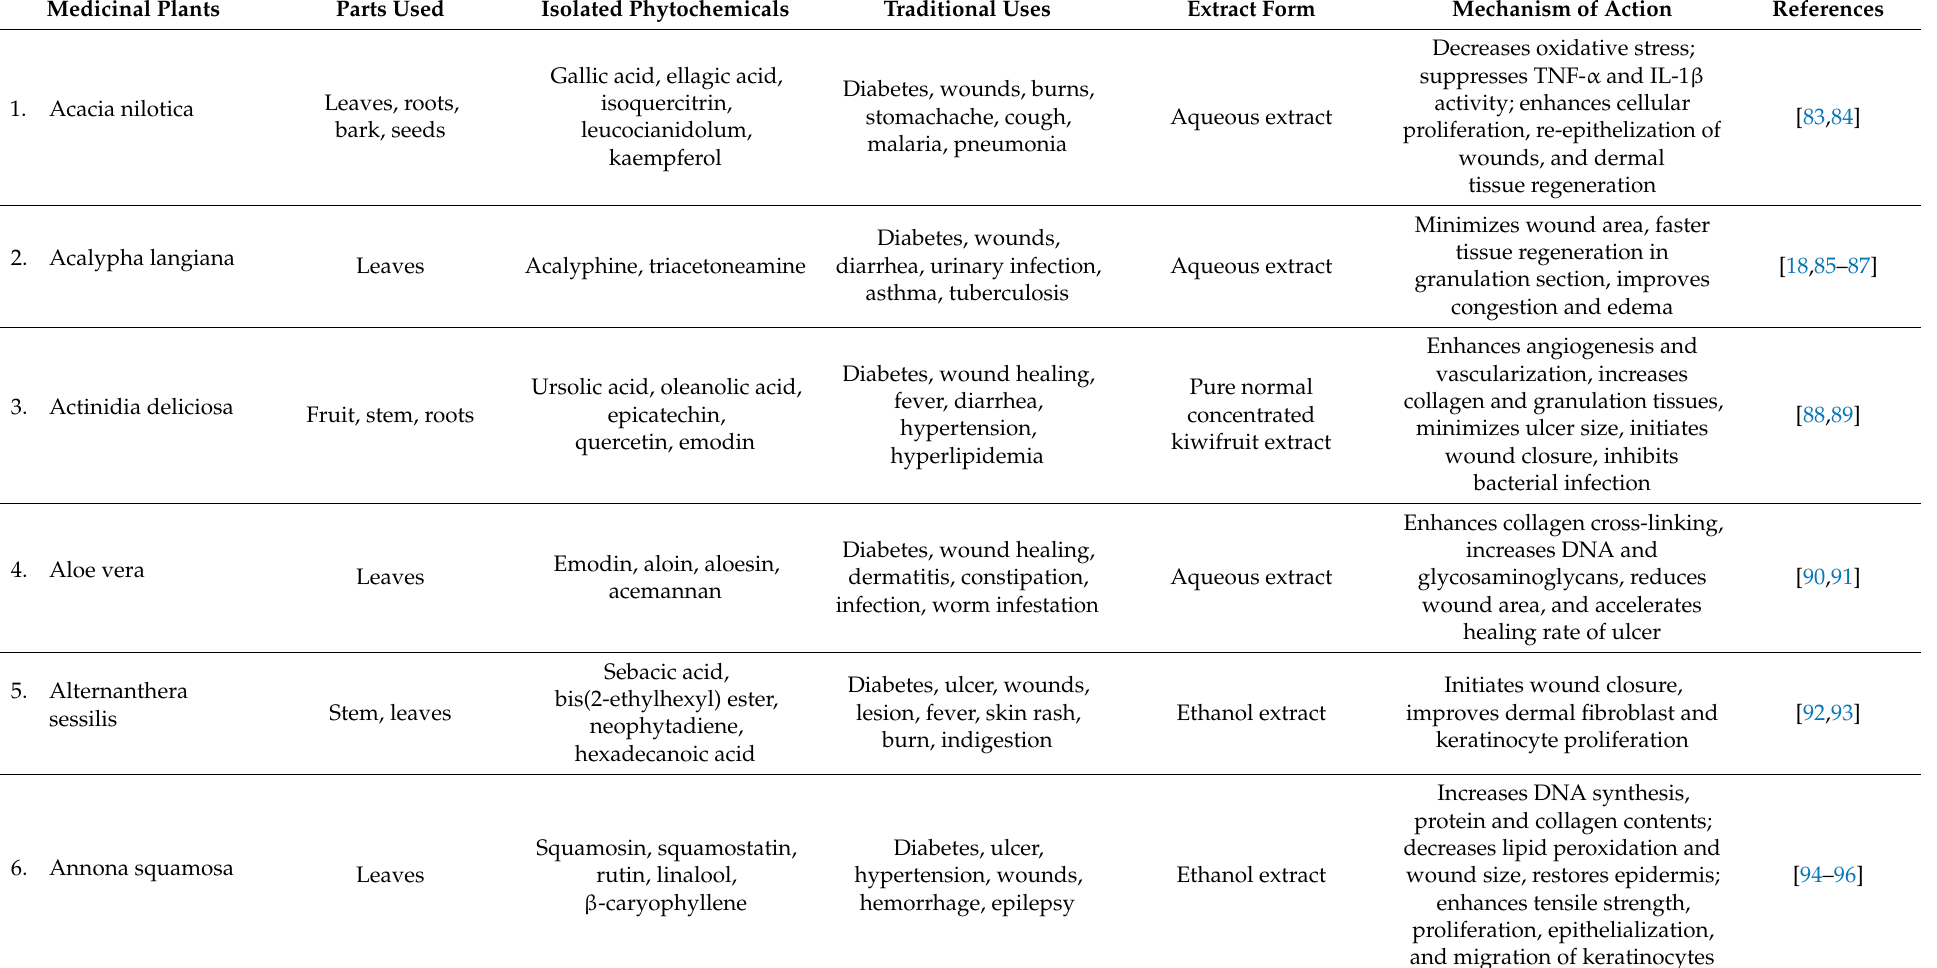
Table 2. Traditional uses, isolated active phytochemicals, and mechanism of action of medicinal plants used to treat diabetic foot